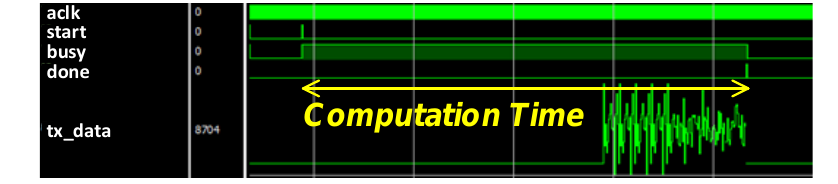
Fig. 7. VLC transmitter timing diagram